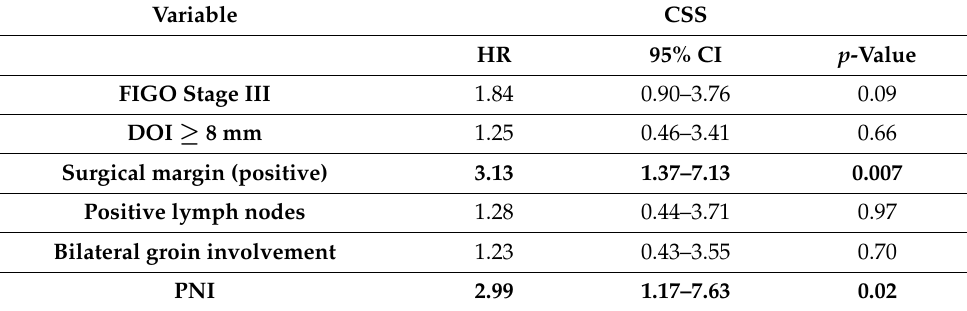
Table 4. Multivariate analysis of factors associated with cancer-specific survival (CSS) (statistically significant factors are highlighted in